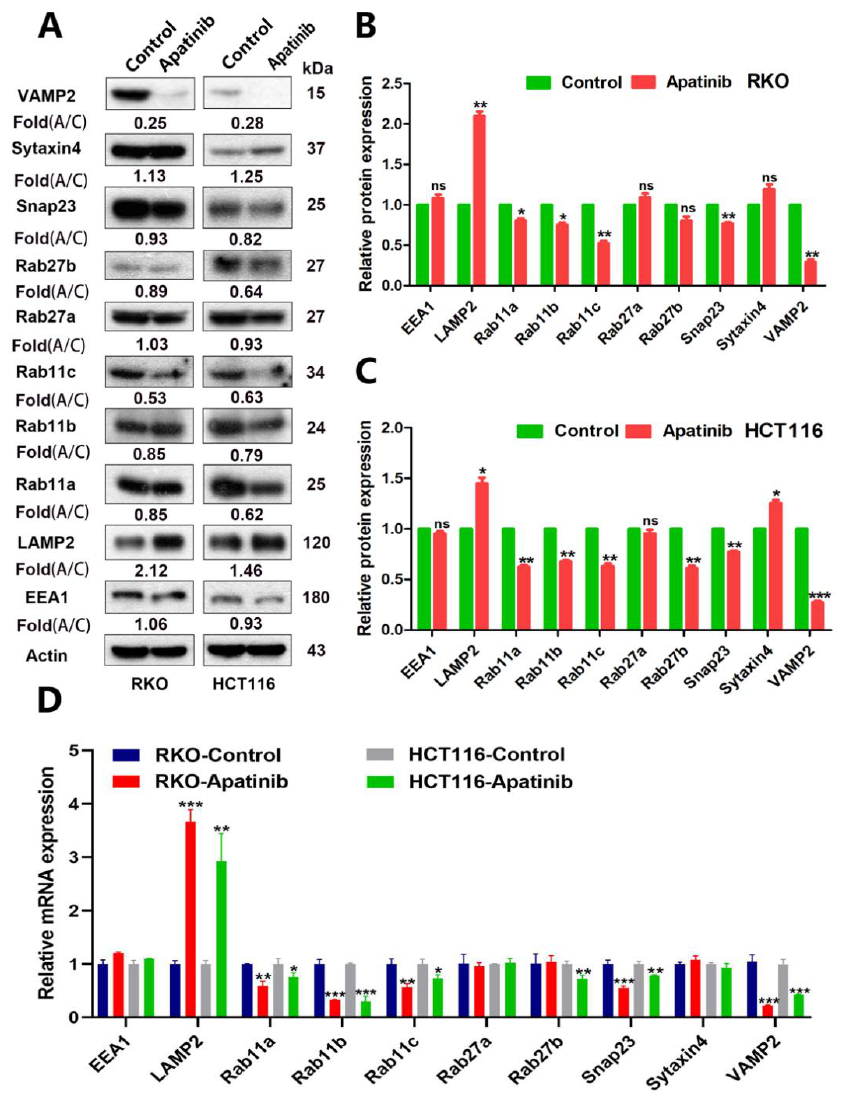
Figure 6. Apatinib regulated the expression of related molecules that were involved in the release of exosomes. ( A – C ) Western blotting analysis of exosome-releasing protein levels from the control and apatinib treatment cells. ( D ) Real-time PCR analysis of the mRNA expression of the exosome- releasing protein in the control and apatinib treatment cells. * p < 0.05, ** p < 0.01, and *** p < 0.001, ns: no